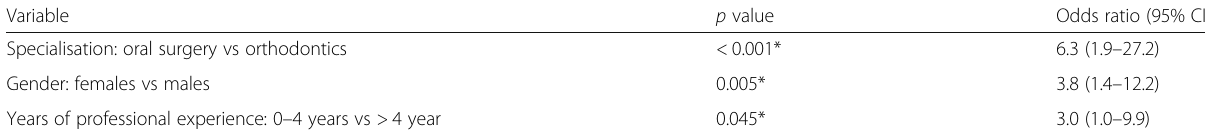
Table 5 Request of CBCT after OPG: influence of residents ’ characteristics Variable p value Odds ratio (95% CI) Specialisation: oral surgery vs orthodontics < 0.001* Gender: females vs males Years of professional experience: 0 – 4 years vs > 4